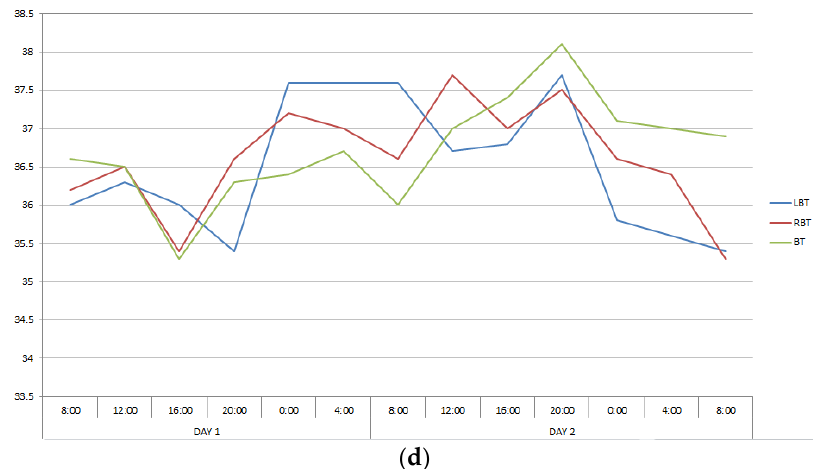
Figure 2. Changes in the LBT, RBT and BT in patients No. 2 ( a ), No. 5 ( b ), No. 11 ( c ), No. 17 ( d ) during the entire measurement period.